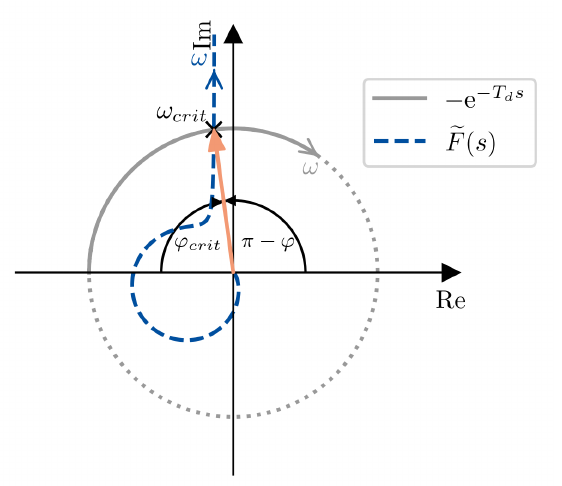
Figure 8. Determining the point where a system is critically stable in the sense of the Satche criterion; the complex vector from the origin to − e − T d s is drawn in